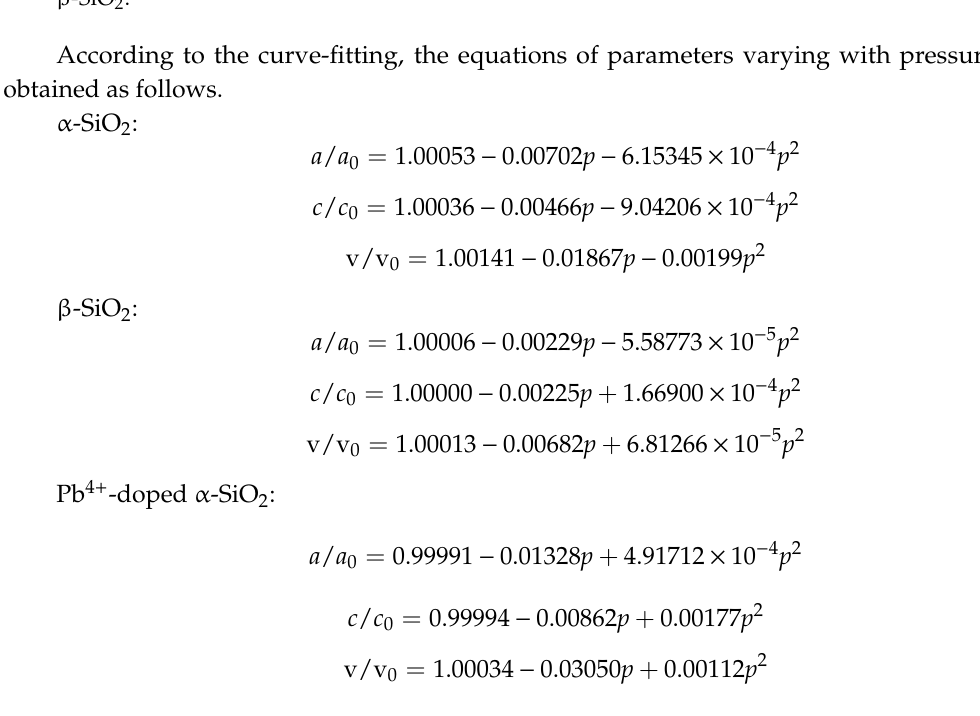
Figure 2. The crystals’ lattice parameters ( a ) α -SiO 2 , ( b ) β -SiO 2 , ( c ) Pb 4 + -doped α -SiO 2 , ( d ) Pb 4 + -doped β -SiO 2